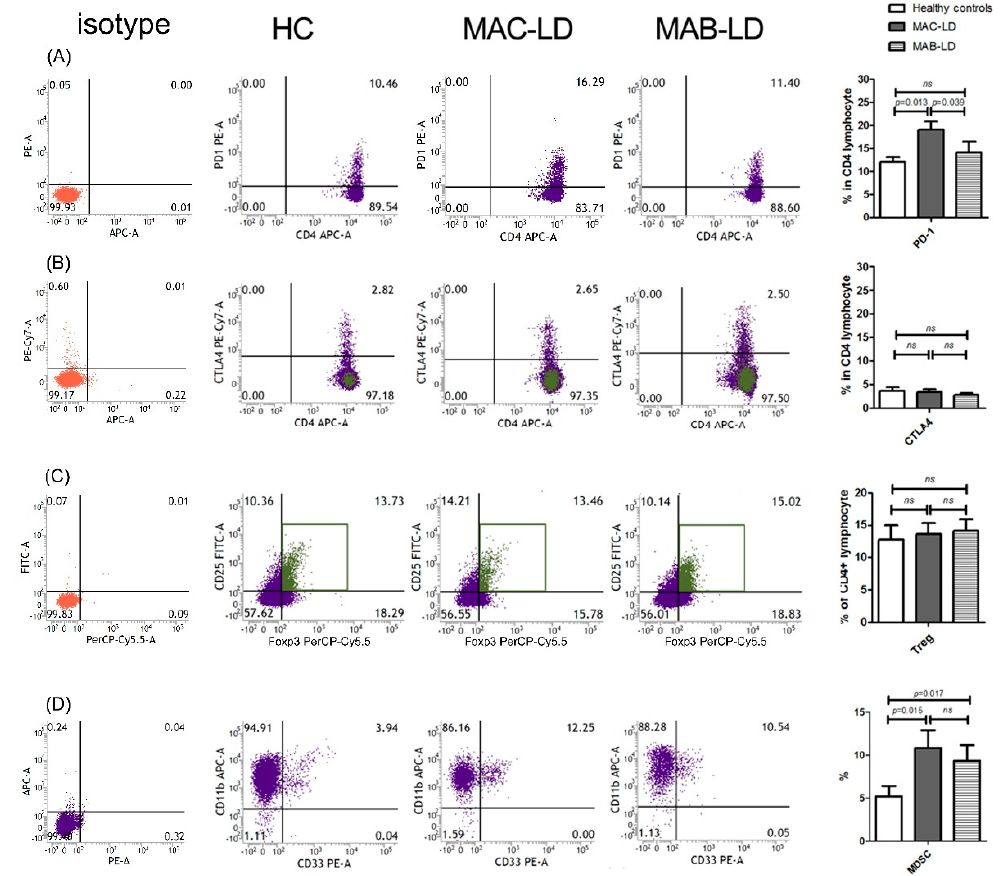
Figure 1. The proportion of ( A ) programmed death-1 (PD-1), ( B ) cytotoxic T-lymphocyte antigen-4 (CTLA-4), and ( C ) regulatory lymphocytes (Treg) in CD4 lymphocytes; ( D ) myeloid derived suppressor cells (MDSCs) according to the status of mycobacterial lung disease. The results shown are case demonstration and bar charts between the controls and patients with Mycobacterium avium complex-lung disease (MAC-LD) and those with Mycobacterium abscessus -LD (MAB-LD). We discriminated the lymphocytes and monocytes by forward scatter (FSC) and side scatter (SSC). We first gated the lymphocyte marker CD4, and then gated PD-1, CTLA-4, and CD25 + / Foxp3 + in the CD4-positive lymphocytes. In Figure 1D, we gated CD3- / CD14- / HLA-DR- cells in peripheral blood mononuclear cells and then gated the CD11b + / CD33 + population. The data in the bar charts are mean values, and error bars are standard errors. The data were compared using the Mann Whitney U test. ns, not statistically significant ( p > 0.05)